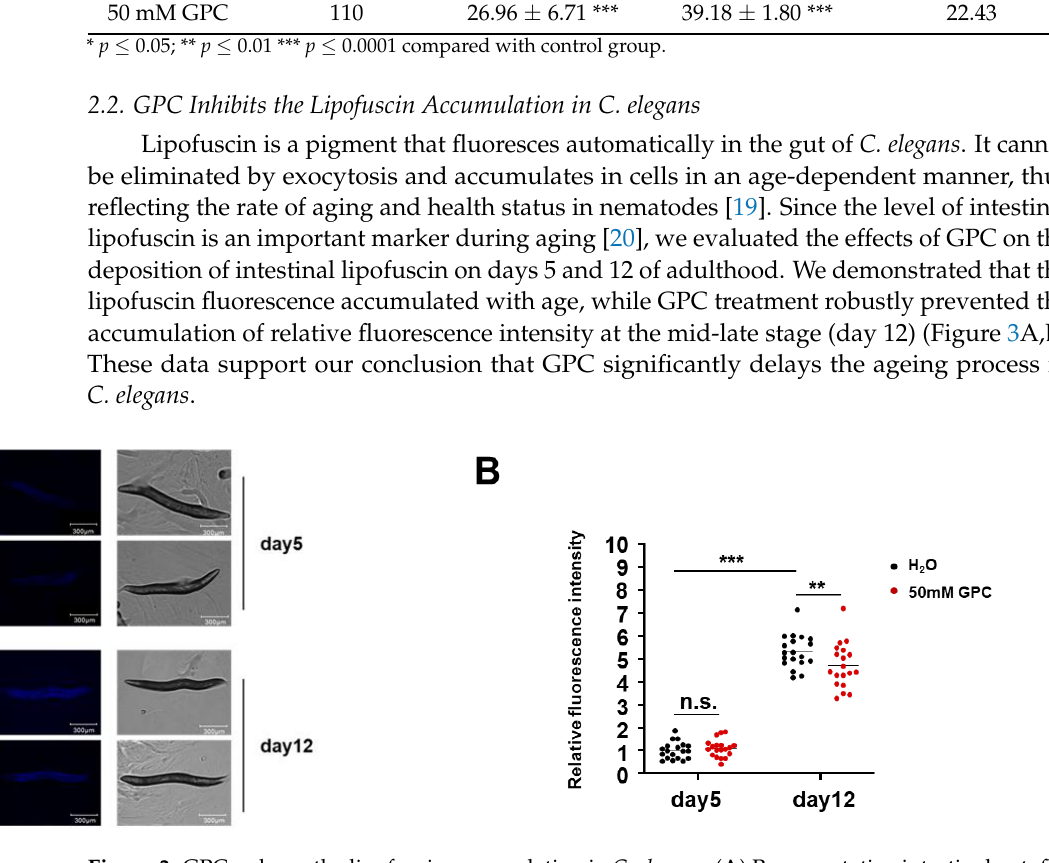
fluorescence and brightfield images ( n = 19 images per group) of worms on days 5 and 12 of adulthood after being treated with 50 mM GPC or vehicle. The blue autofluorescence in the figure indicates the accumulation of lipofuscin. Scale bars, 300 µm. ( B ) The comparison of relative fluorescence intensity of intestinal autofluorescence in groups as indicated in A. ** p ≤ 0.01; *** p ≤ 0.0001; n.s., not significant; by two-way analysis of variance (ANOVA) followed by Bonferroni tests. Values are mean ±